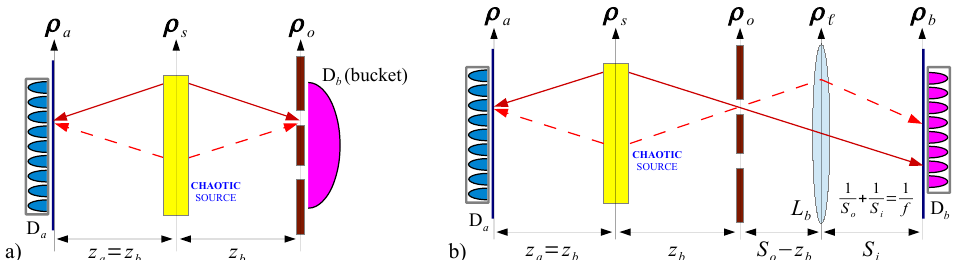
Figure 2. Unfolded setups (Klyshko-like pictures) of ghost imaging ( a ) and correlation plenoptic imaging ( b ) with chaotic light, as referred to the focused case z a = z b . Adapted with the permission from [40], copyright Walter de Gruyter GmbH, 2016. In ghost imaging, a bucket detector collects light transmitted by the object, with neither spatial nor directional resolution. In CPI, the high-resolution detector D b enables measuring point-by-point intensity correlations between the two sensors and simultaneously reconstruct both the transmission profile of the object and the propagation direction of light from the source to the